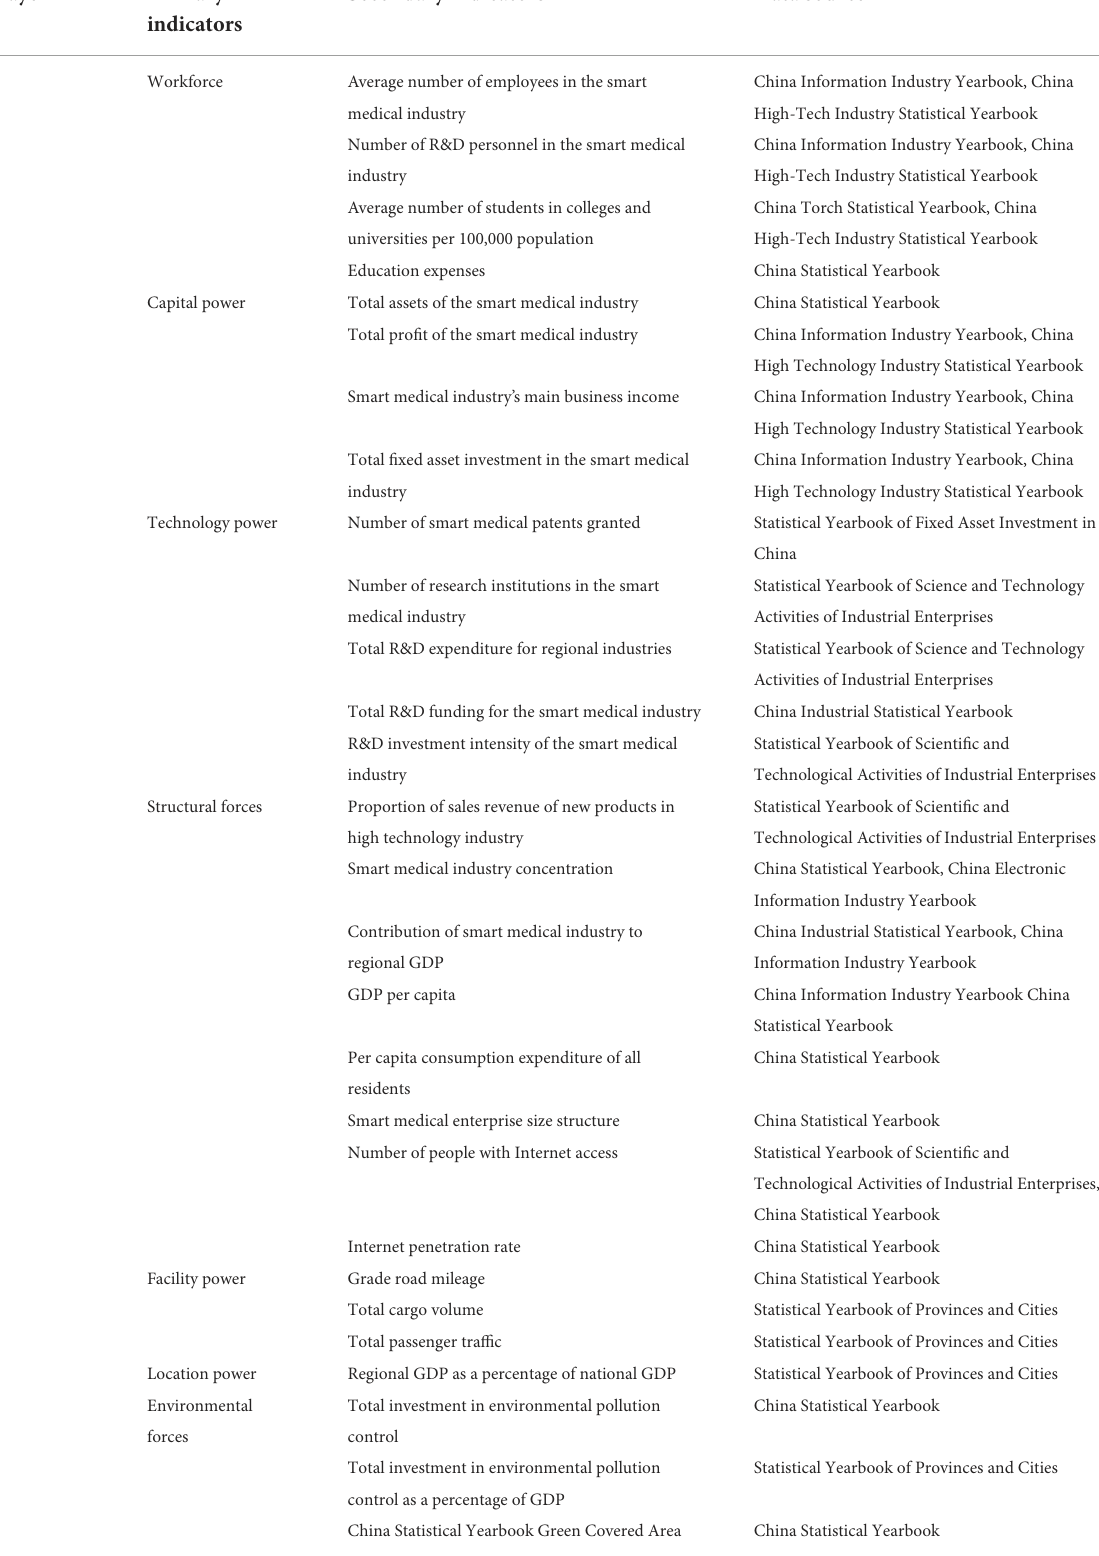
TABLE 2 Evaluation index system of smart medical industry development in the Yangtze River Economic